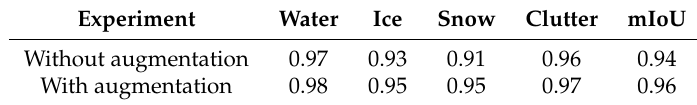
Table 16. Effect of data augmentation (IoU values) on the same camera train/test experiment (camera 0).